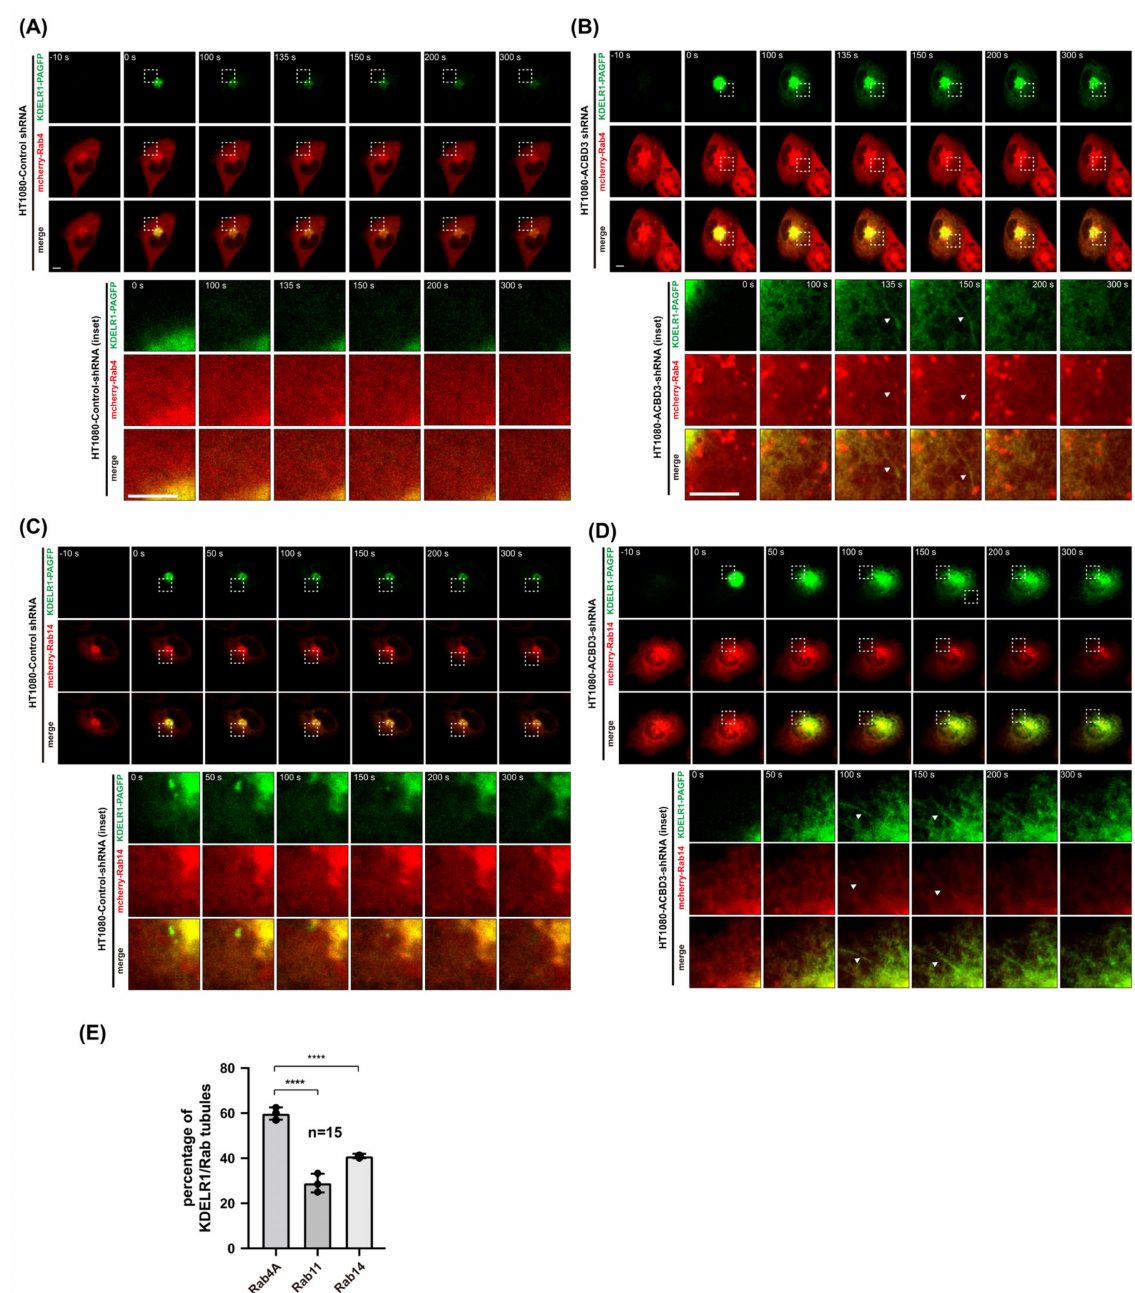
Figure 3. ACBD3 depletion results in increased trafficking of KDEL receptor to the PM via Rab4A- positive tubular carriers at the Golgi. ( A – D ) To examine the post-Golgi trafficking itineraries of KDEL receptor to the PM, WT or ACBD3-depleted HT1080 cells were co-transfected with photoactivatable KDELR1-PA-GFP and mCherry-Rab4A/14 plasmids for 18 h. The KDELR1-PA-GFP in the Golgi were then activated by selecting an ROI of the mCherry-Rab4A/14 perinuclear region for intense 405 nm laser irradiation, and the transport out of the Golgi was monitored via live cell imaging acquired every 5 s for 5 min. Imaging sequences prior to photoactivation ( − 10 s) and immediately after photoactivation (0 s), and the indicated time points following photoactivation, are presented here. Magnified regions of interest (indicated by white boxes) from WT and ACBD3-KO cells at the indicated time points show Golgi-derived tubules which are highlighted by white arrowheads. Scale bars = 5 µ m. ( E ) Bar graphs showing the percentage of KDELR1/Rab tubules present in ACBD3- depleted HT1080 cells. N = 15 cells. Statistical analysis was performed using one-way ANOVA with a Tukey’s post hoc test (mean ± SD; ****, p <